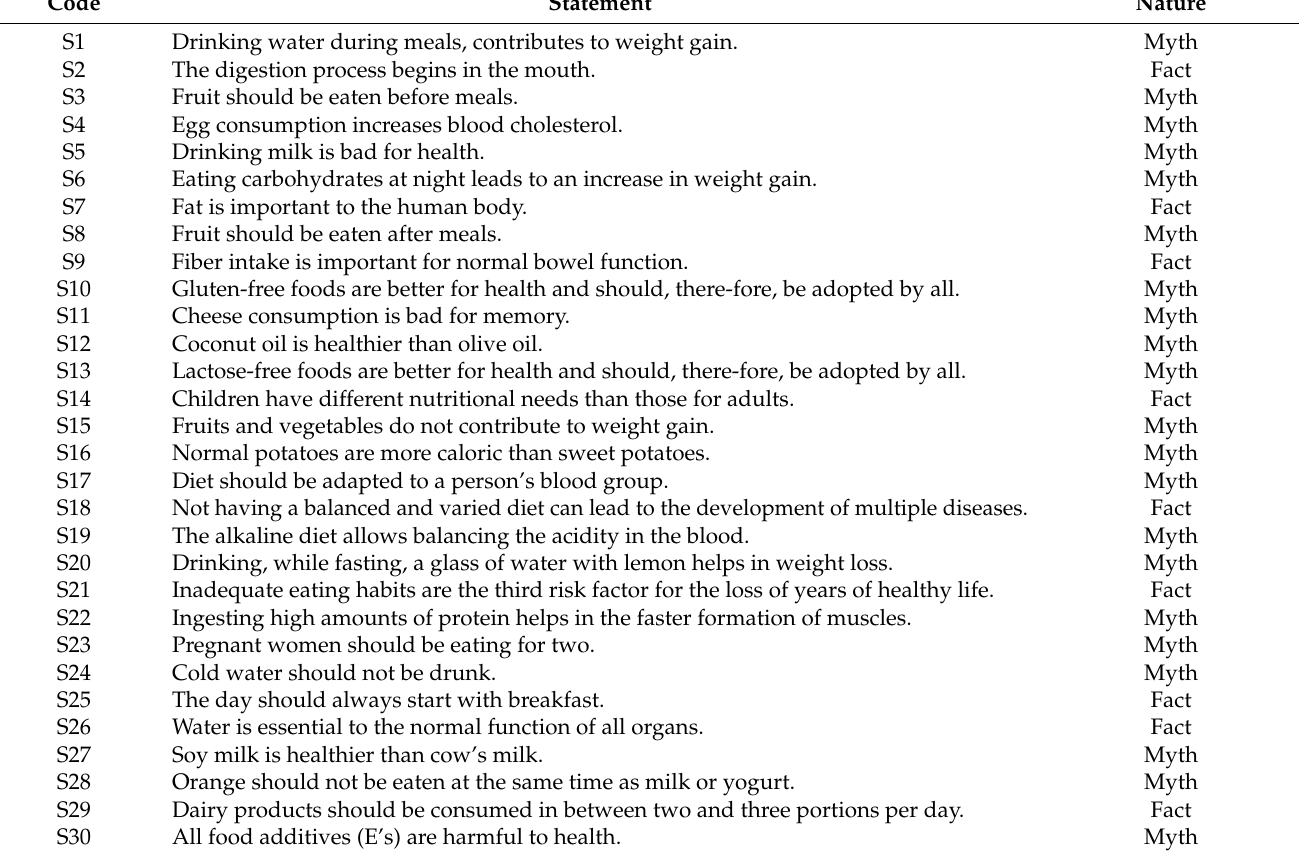
Table 1. Myths and facts used in the